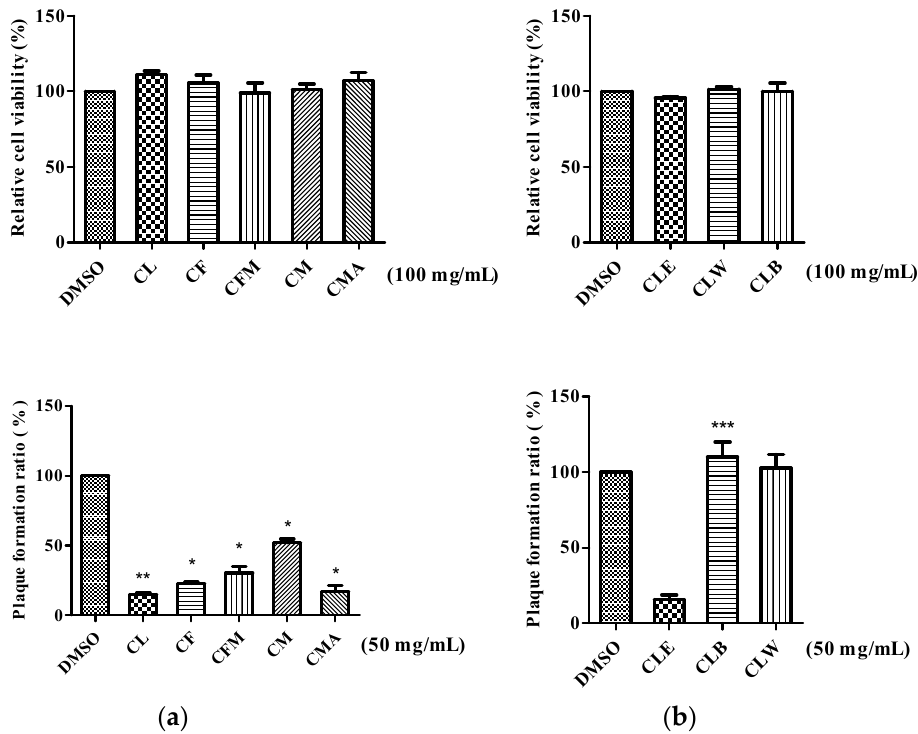
Figure 2. Anti-IAV activity of the extracts, fractions, and isolated compounds using the viral plaque reduction assay on MDCK cells with A/WSN/33 (H1N1) virus. ( a ) The anti-IAV activity of the CL, CF, CFM, CM, and CMA extracts. Cell viability was shown in upper panel and plaque forming reducing was shown in bottom panel. ( b ) The anti-IAV activity of the EtOAc (CLE), BuOH (CLB), and H 2 O (CLW) layers from CL extract. Cell viability was shown in the upper panel and plaque forming reducing is shown in the bottom panel. The data are presented as mean ± SD of three independent experiments and were normalized to the data of solvent control (* p < 0.05, ** p < 0.01 and *** p < 0.001).